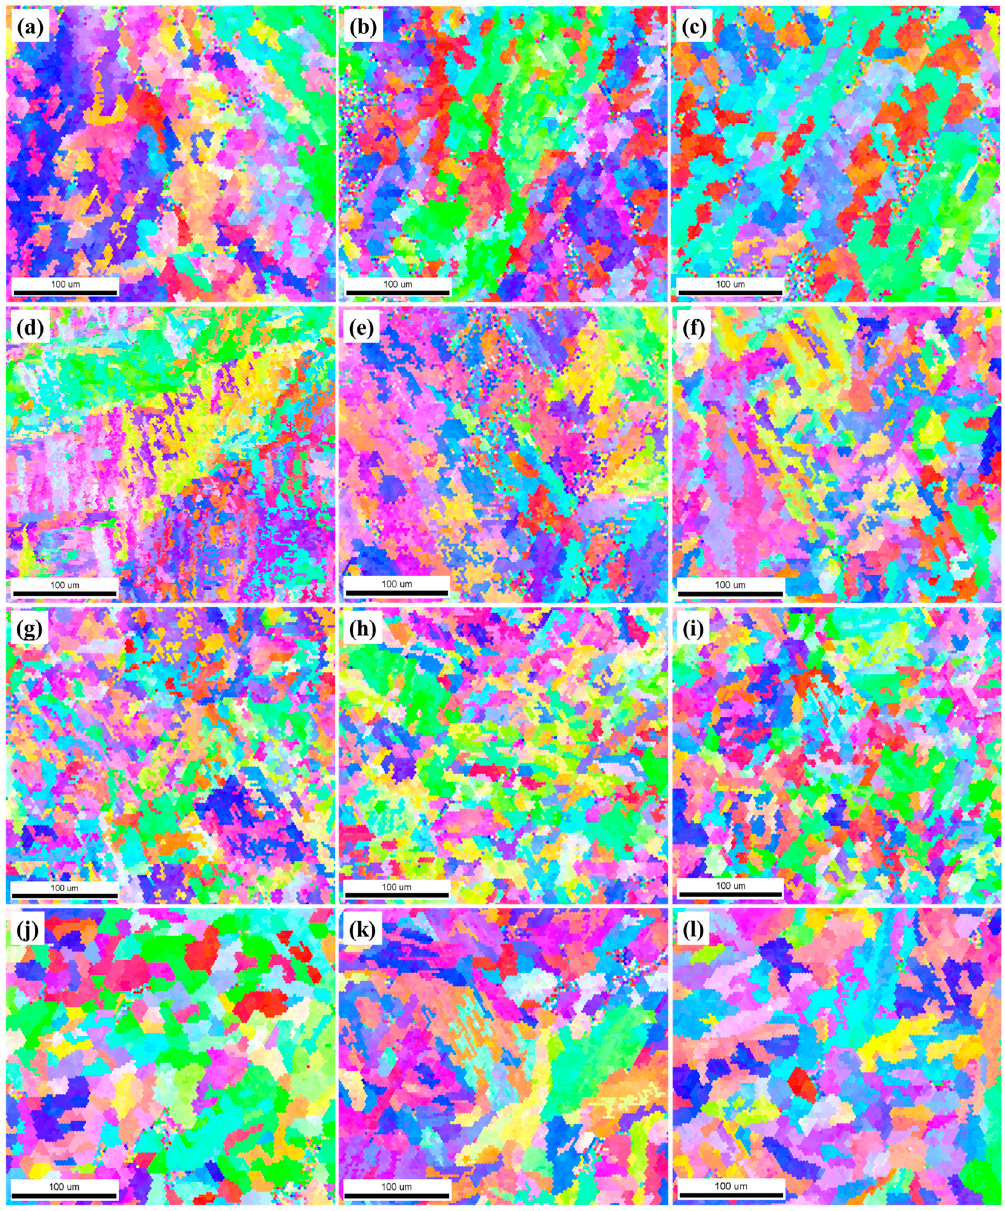
Figure 5. EBSD images showing microstructural features for the specimens tested at different temperatures: ( a ) unadded steel at 800 °C; ( b ) P ‐ added steel at 800 °C; ( c ) P+Ce ‐ added steel at 800 °C; ( d ) unadded steel at 850 °C; ( e ) P ‐ added steel at 850 °C; ( f ) P+Ce ‐ added steel at 850 °C; ( g ) unadded steel at 900 °C; ( h ) P ‐ added steel at 900 °C; ( i ) P+Ce ‐ added steel at 900 °C; ( j ) unadded steel at 1000 °C; ( k ) P ‐ added steel at 1000 °C; and ( l ) P+Ce ‐ added steel at 1000 °C.